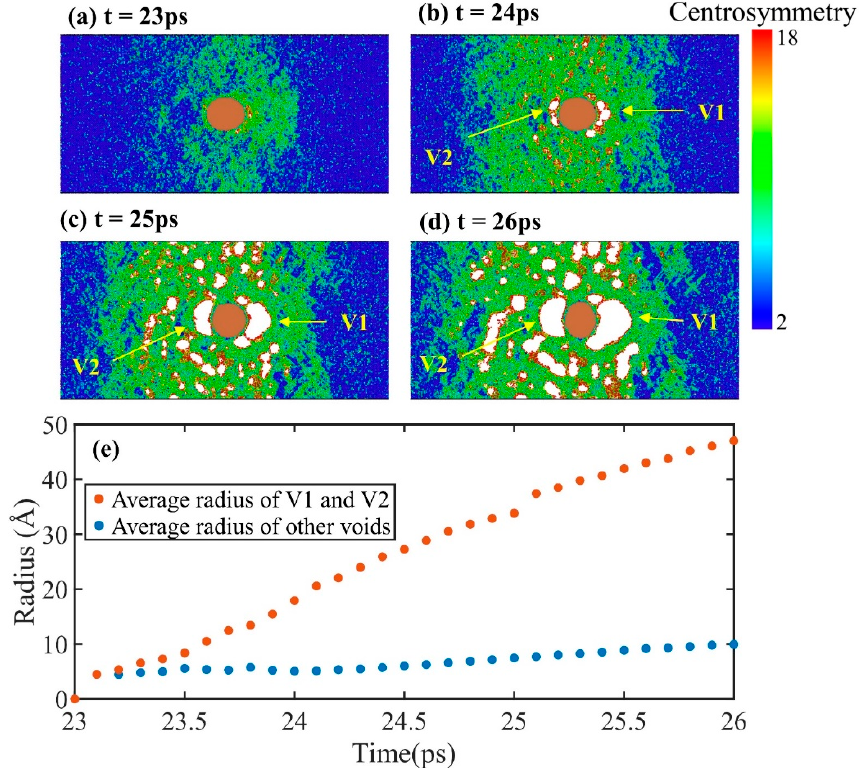
Figure 10. Microstructure evolutions of Al–Cu during spallation at u p = 2.0 km/s. The atoms are color-coded by CSP. ( a ) t = 23 ps; ( b ) t = 24 ps; ( c ) t = 25 ps; ( d ) t = 26 ps. ( e ) Evolution of the average radius of voids V1 and V2 and the average radius of other voids over time.